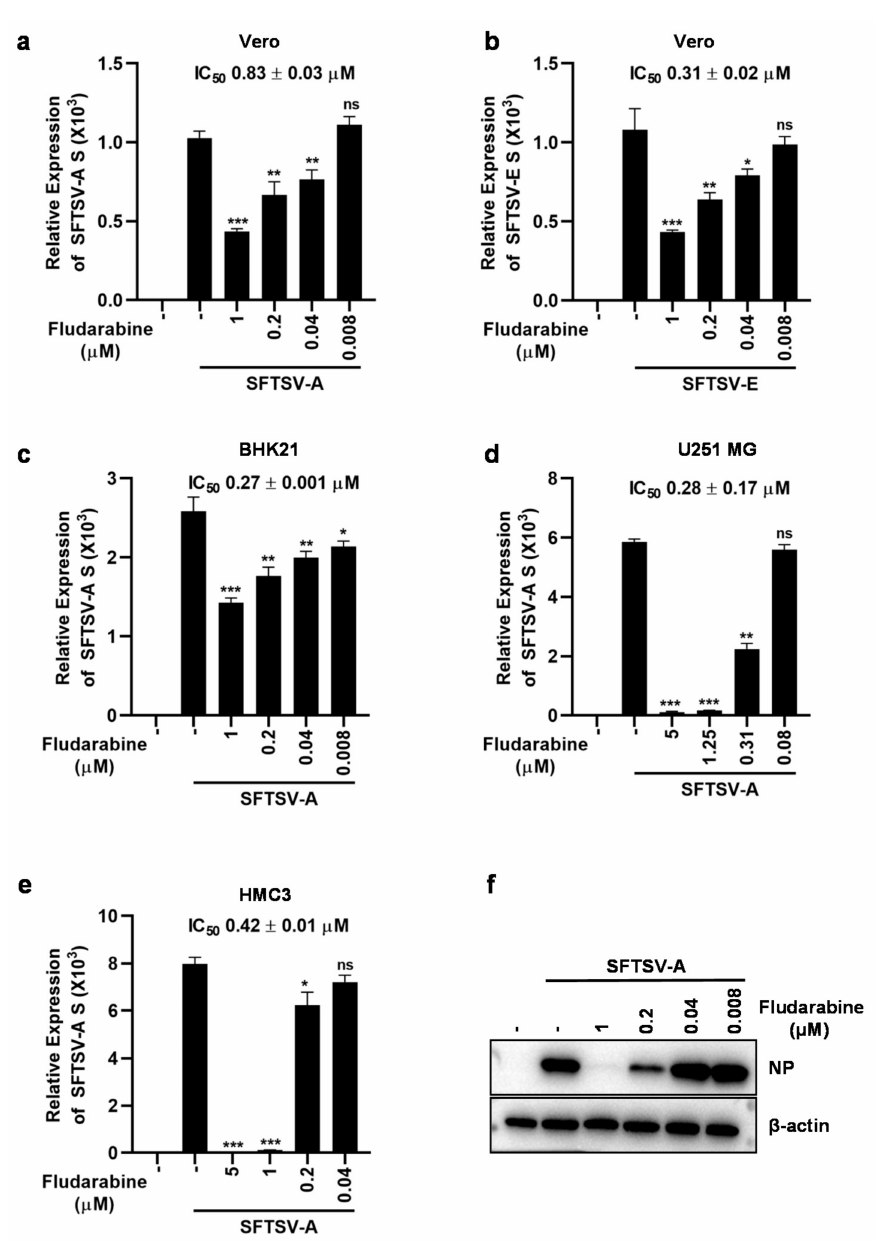
Figure 3. Fludarabine inhibited infection of SFTSV. ( a – e ) Inhibitory effect of fludarabine on SFTSV-A or SFTSV-E infection in Vero, BHK21, U251 MG and HMC3 cells. Fludarabine, diluted to 1, 0.2, 0.04, and 0.008 µ M or 5, 1.25, 0.31, and 0.08 µ M, was mixed with 0.1 MOI of SFTSV-A or SFTSV-E. After the mixture was inoculated to cells for 2 h, the mixture was discarded and the cells were washed twice with PBS. The cell cultures were supplemented with DMEM or MEM (2% FBS) containing fludarabine of the same concentration as mentioned above. Total RNA was prepared 24 h later to measure SFTSV S gene transcripts by qRT-PCR assay. The differences between infected-groups without and with treatment of fludarabine were evaluated by two-tailed Student’s t test. Data are presented as mean ± SD; *, p < 0.05; **, p < 0.01; ***, p < 0.001; ns, no significance; -, no fludarabine was added. ( f ) Anti-SFTSV activity of fludarabine was evaluated by western blot analysis. The expression of SFTSV-A nucleoprotein (NP) was measured by western blot analysis after the Vero cells were treated for 36 h as mentioned above. -, no fludarabine was